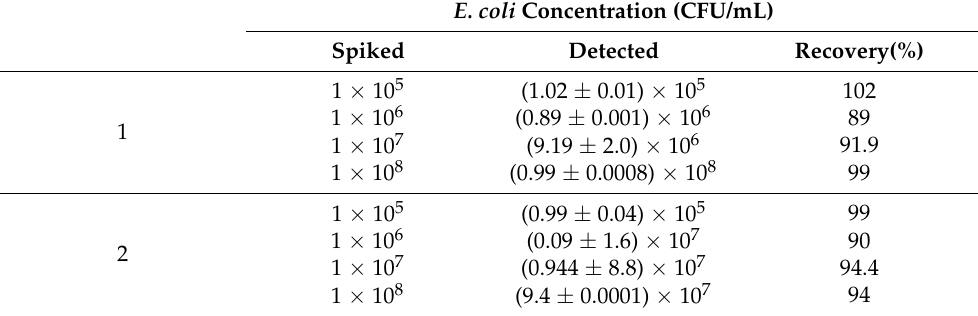
Table 2. Recovery of E. coli in fecal samples .